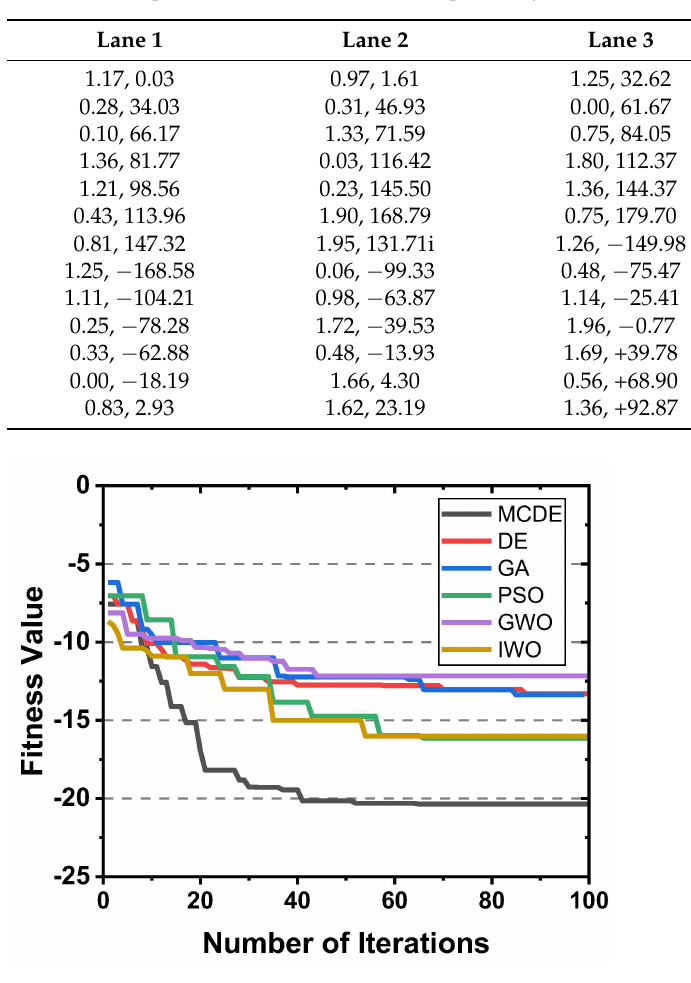
Figure 7. Iterations for the MCDE and benchmark